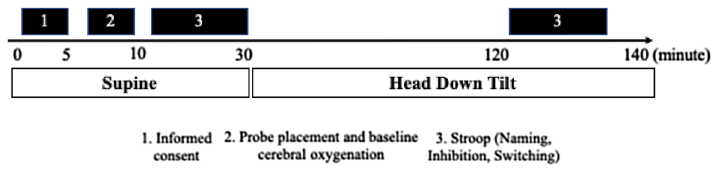
Figure 1. Timeline of procedures during the HDT session.